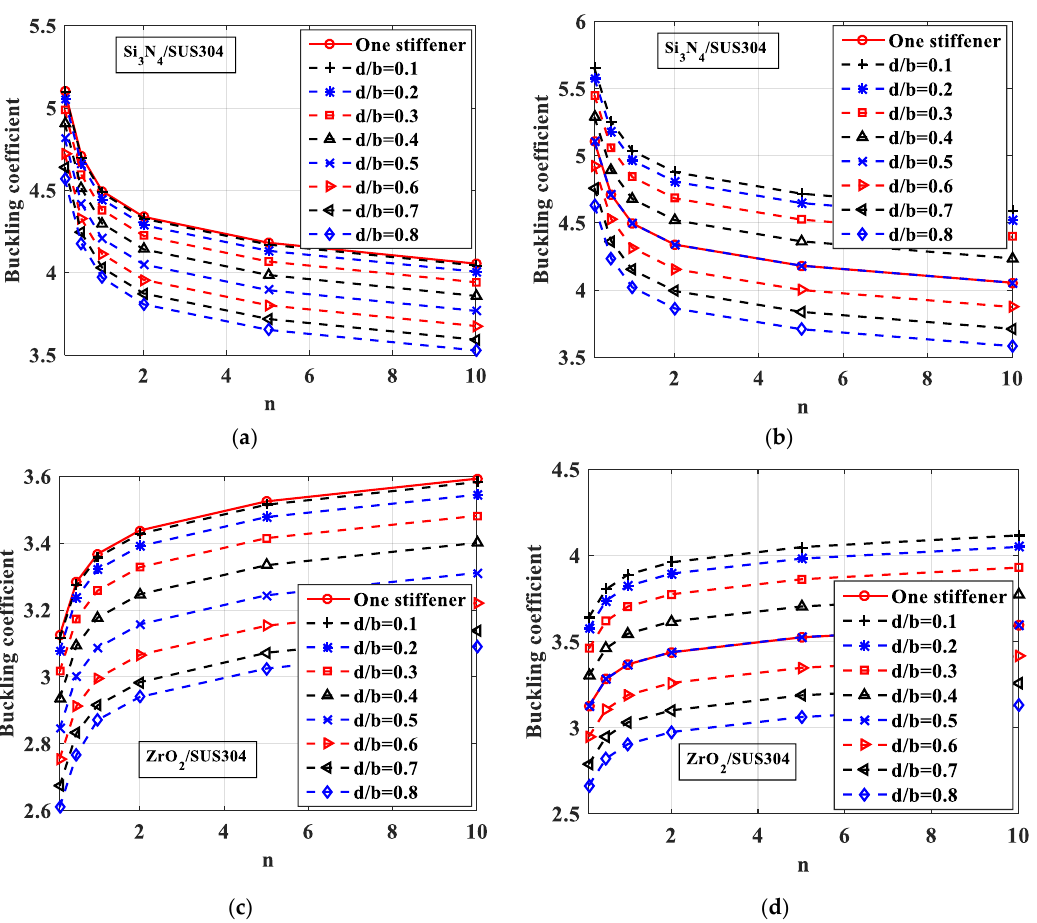
Figure 14. Buckling coefficient of the plate with one stiffener and two stiffeners. ( a , c ) Plate with two stiffeners b s = b /200 and plate with one central stiffener; ( b , d ) plate with two stiffeners b s = b /100 and plate with one central stiffener.